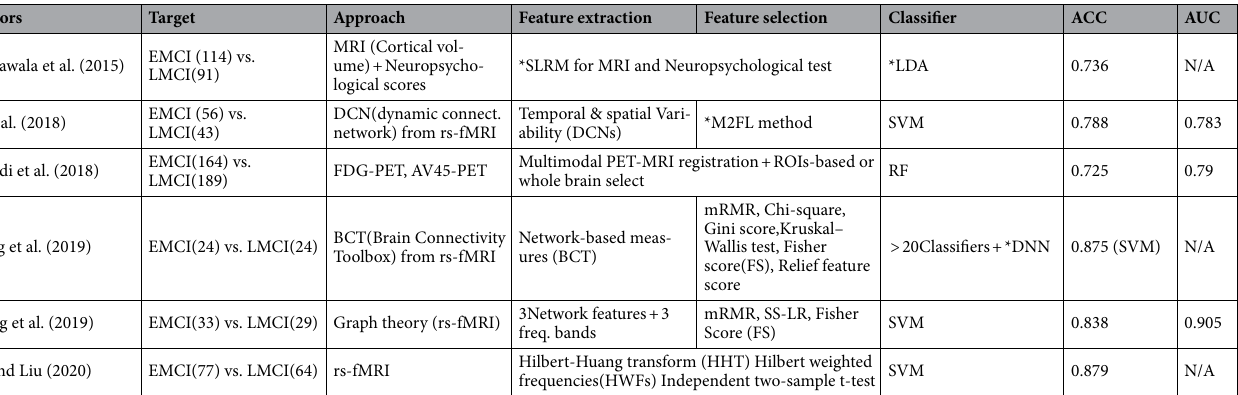
Table 2. Comparison with previous studies for EMCI/LMCI classification. * SLRM stepwise linear regression models. * M2FL method Manifold regularized multi- task feature selection. * DCN dynamic connectivity network. * LDA linear discriminant analysis. * DNN deep neural